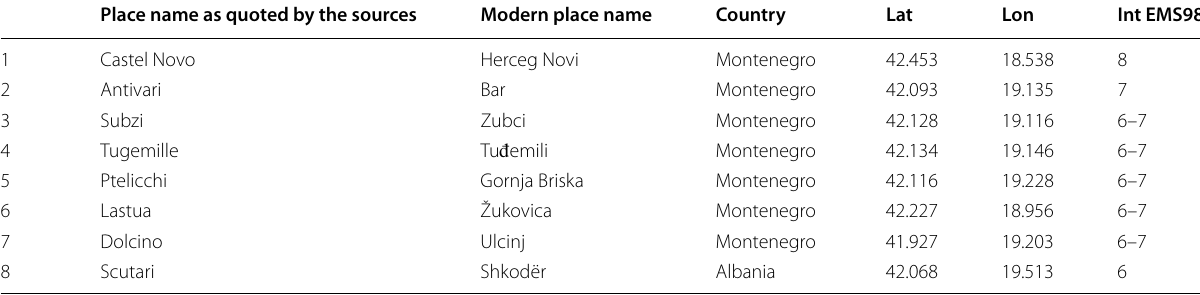
Table 5 Affected places in the Ottoman